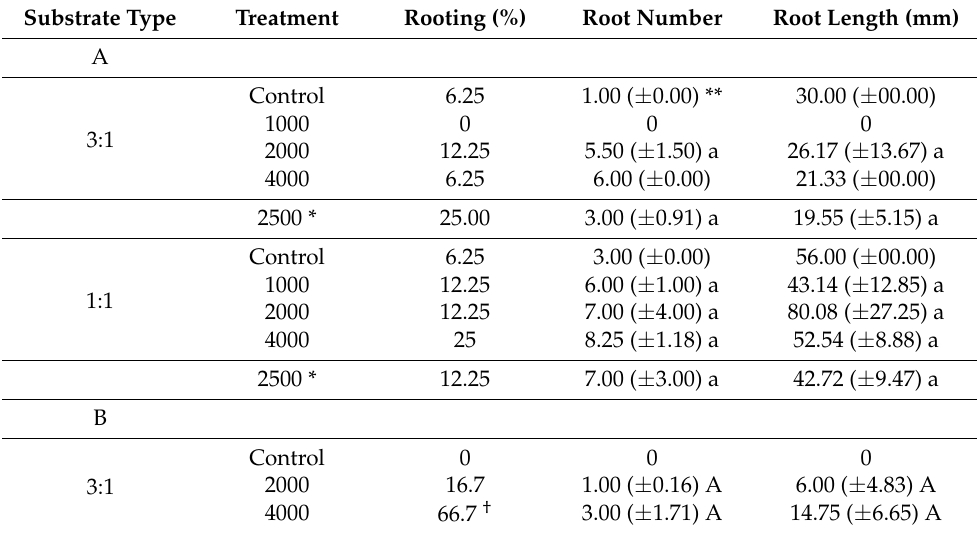
Table 5. Rooting attributes of the prioritized Rosa canina genotype GR-1-BBGK-03,2229 in experiments of 2019 (A) and 2020 (B) expressed as rooting percentage (%) and mean values of root number ( ± SEM, p < 0.05) and average root length (mm) of rooted cuttings for each hormone treatment (ppm IBA) and substrate type. All cuttings were soft-wood, leafy sections of the first growth year. The two substrate type ratios shown refer to perlite/peat ( v/v ) under mist conditions. Values within each column that do not share the same letter are significantly different (Tukey HSD, p < 0.05, lowercase letters for 2019 and capital letters for 2020). Original data are included in Table S3.